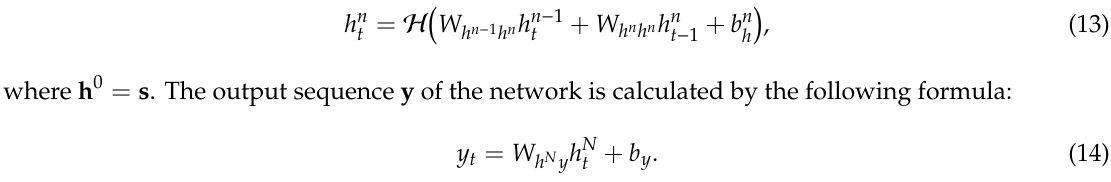
Figure 7. A typical radio signal for the experiment. The model of the digital radio is AKDS700 (ANYKEY, Wuhan, China). A typical radio signal is shown in Figure 7. The model of the receiver is an SSC024 ultrashort wave digital receiver (Changzhou Radio Factory Co.,Ltd., Changzhou, China) with a bandwidth of 20 MHz. The oscilloscope model is a LeCroy Master 8500A (Teledyne LeCroy, New York, NY, USA). The length of collected data is 1 s. Since the distance between the horn antenna and the transmitting side is about 15 cm, this channel can be approximated as an ideal channel, i.e.,